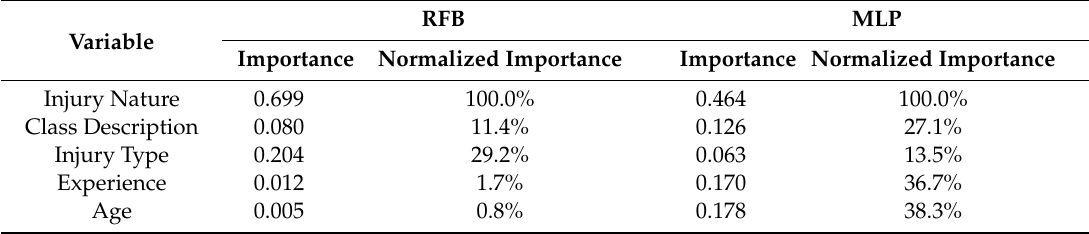
Table 7. Sensitivity Analysis of Independent variables importance.